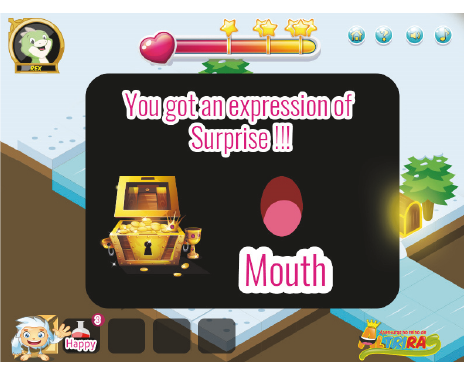
Figure 18: Selected expressions. Table 2: Average SUS score referring to the quality components of the game ALTRIRAS: nondisabled children.